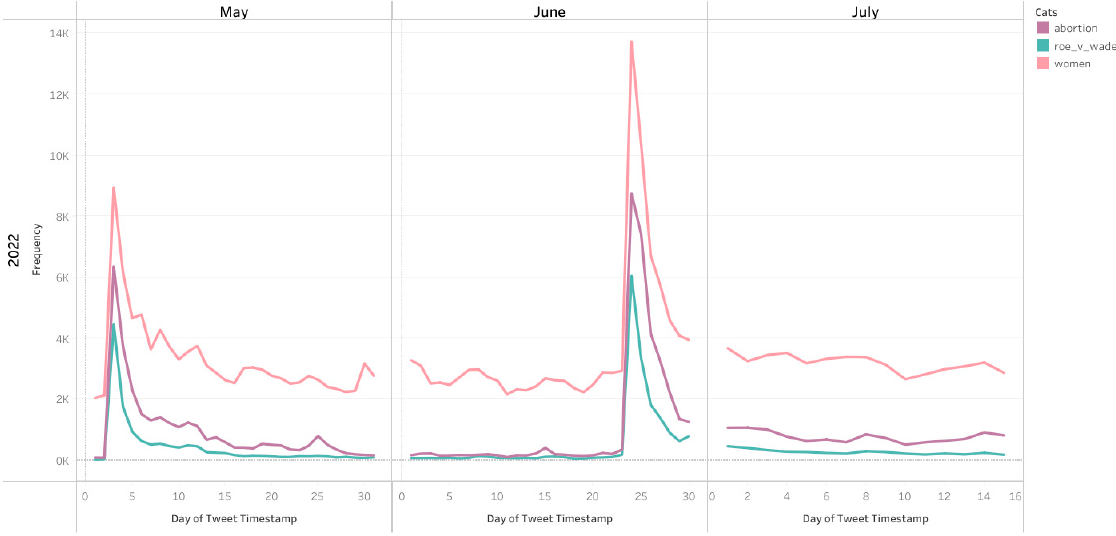
Figure 5. Number of Tweets about Abortion, Roe v Wade, and Women from 1 May–15 July 2022.